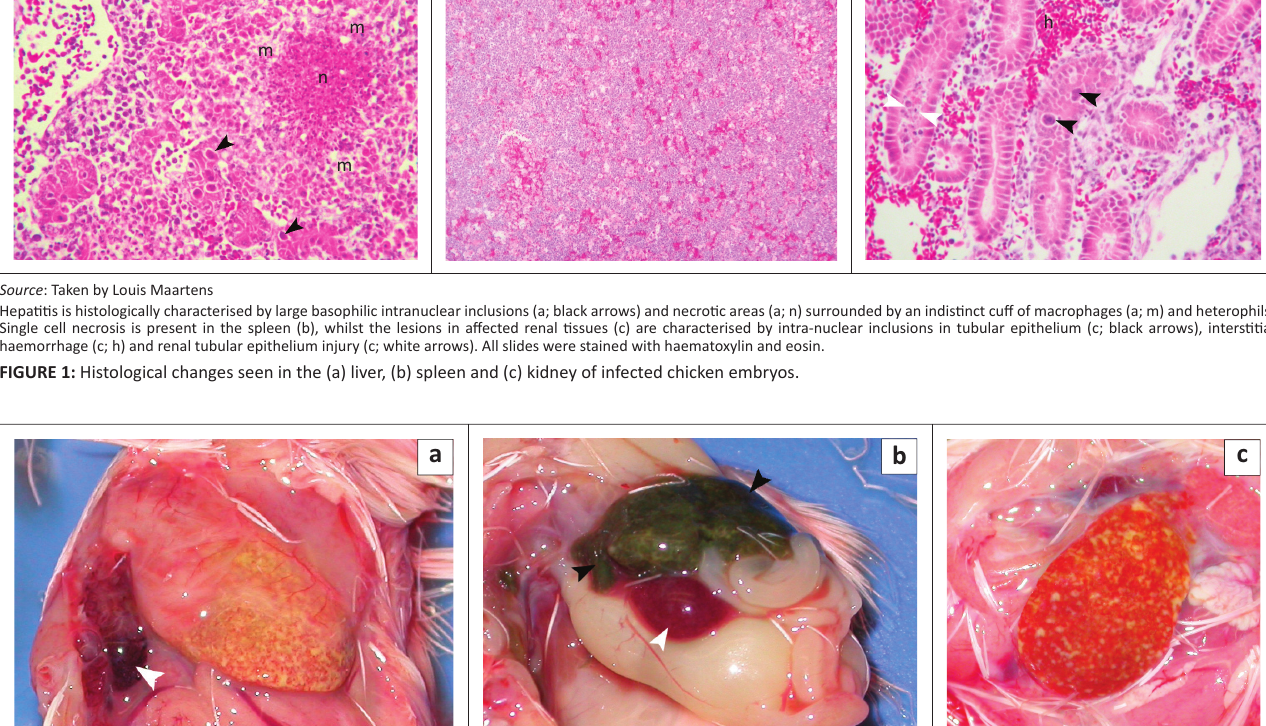
FIGURE 2: Macroscopic pathological changes in the livers of infected chicken